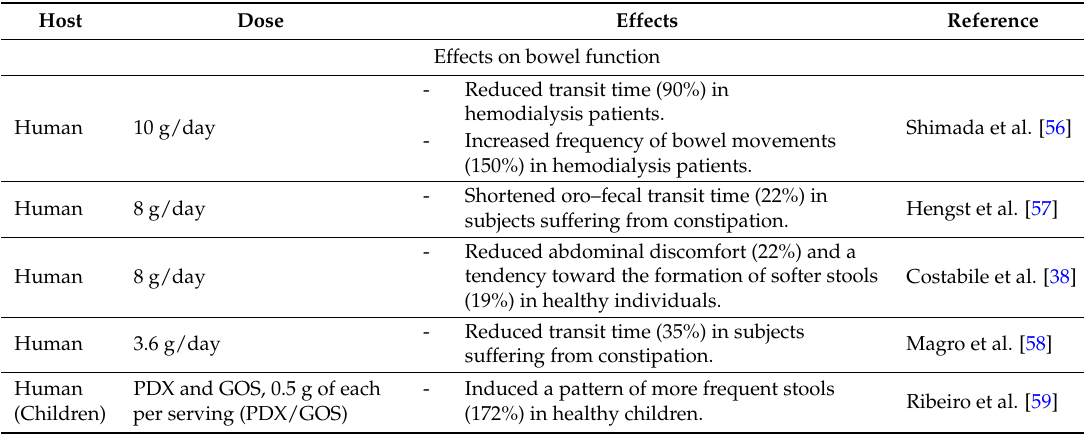
Table 5. The effects of administration of polydextrose on bowel